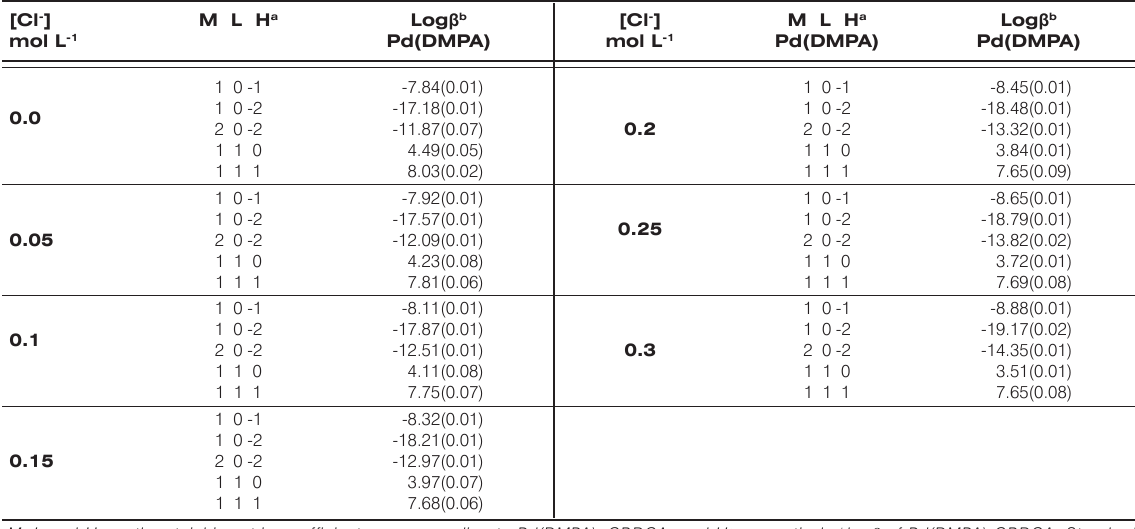
a M, L and H are the stoichiometric coefficients corresponding to Pd(DMPA), CBDCA, and H + respectively; b log β of Pd(DMPA)-CBDCA. Standard deviations are given in parentheses; sum of square of residuals are less than 6×10 -8 . Table 4. Formation constants for complexes of [Pd(DMPA)(H Temp.